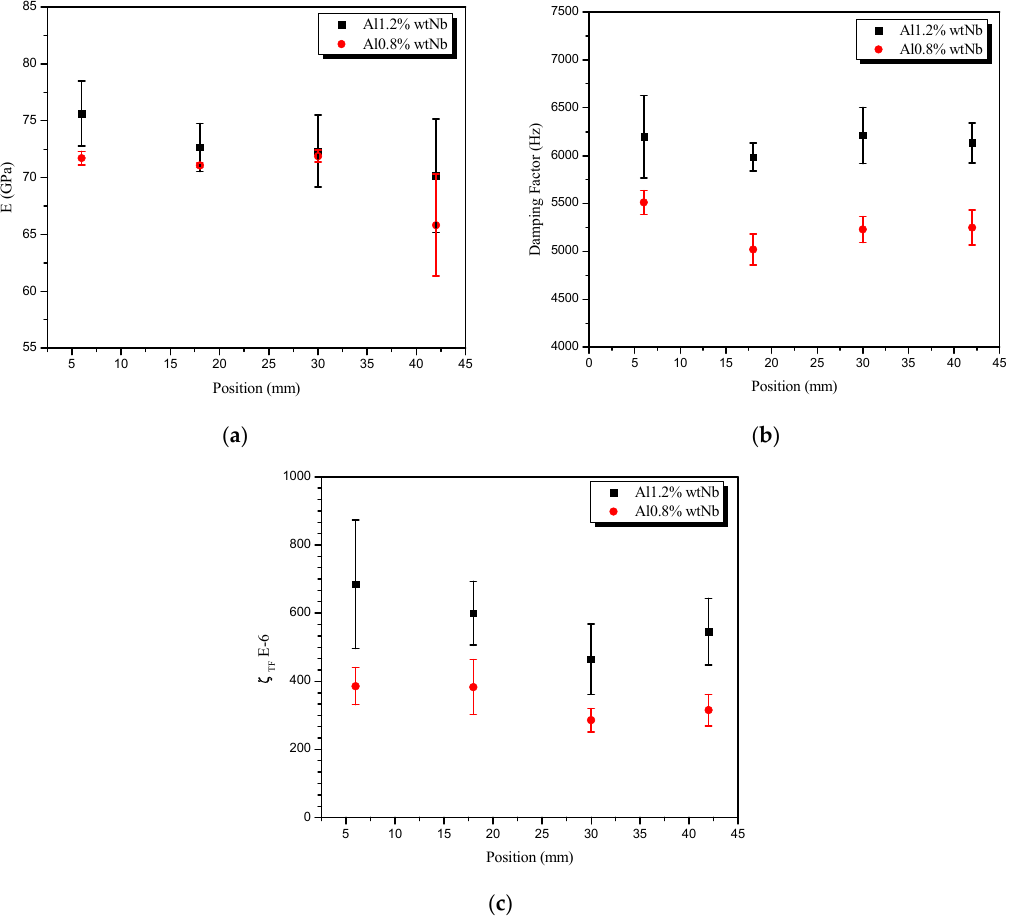
Figure 15. ( a ) The modulus of elasticity, ( b ) the damping frequency, and ( c ) damping, in relation to the position of the metal/mold interface.